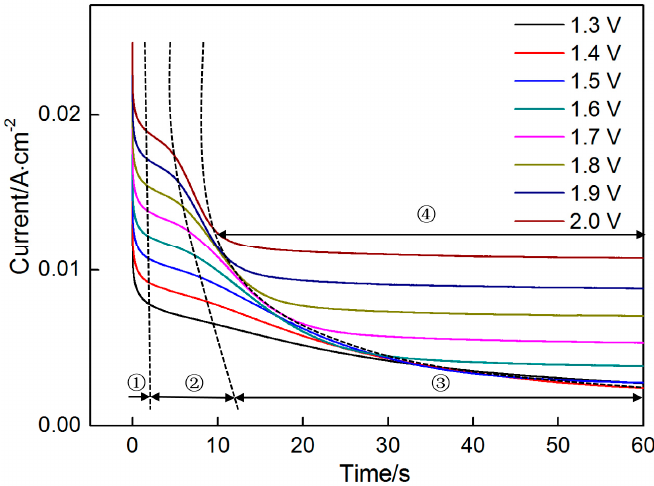
Figure 3. Chronoamperograms recorded on graphite flake in 0.14 M MnSO 4 electrolyte at different step potentials ranging from 1.3 V to 2.0 V.